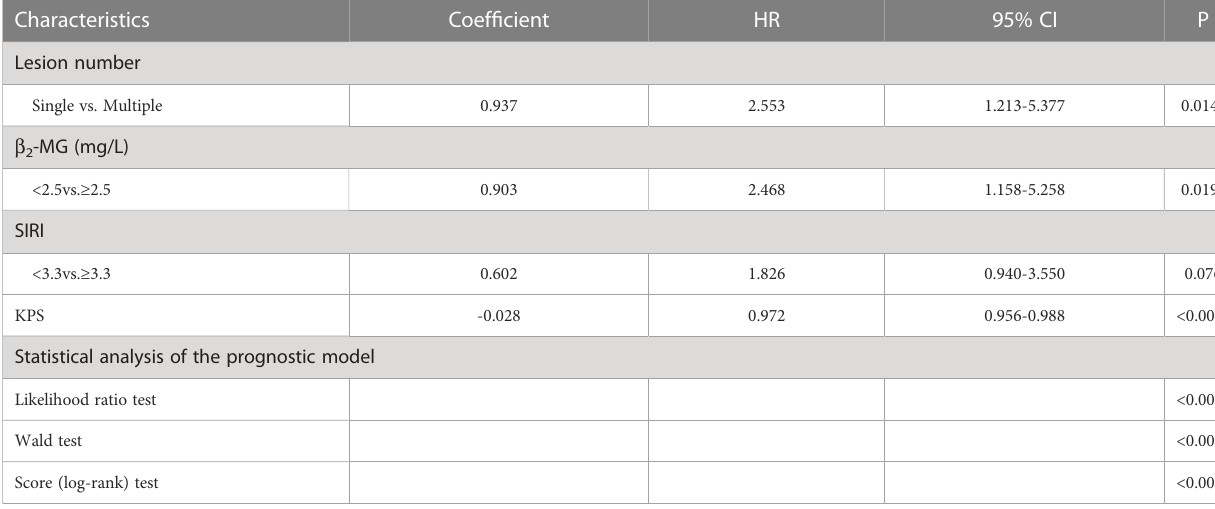
TABLE 3 Multivariate Cox regression analysis in the development cohort. Characteristics